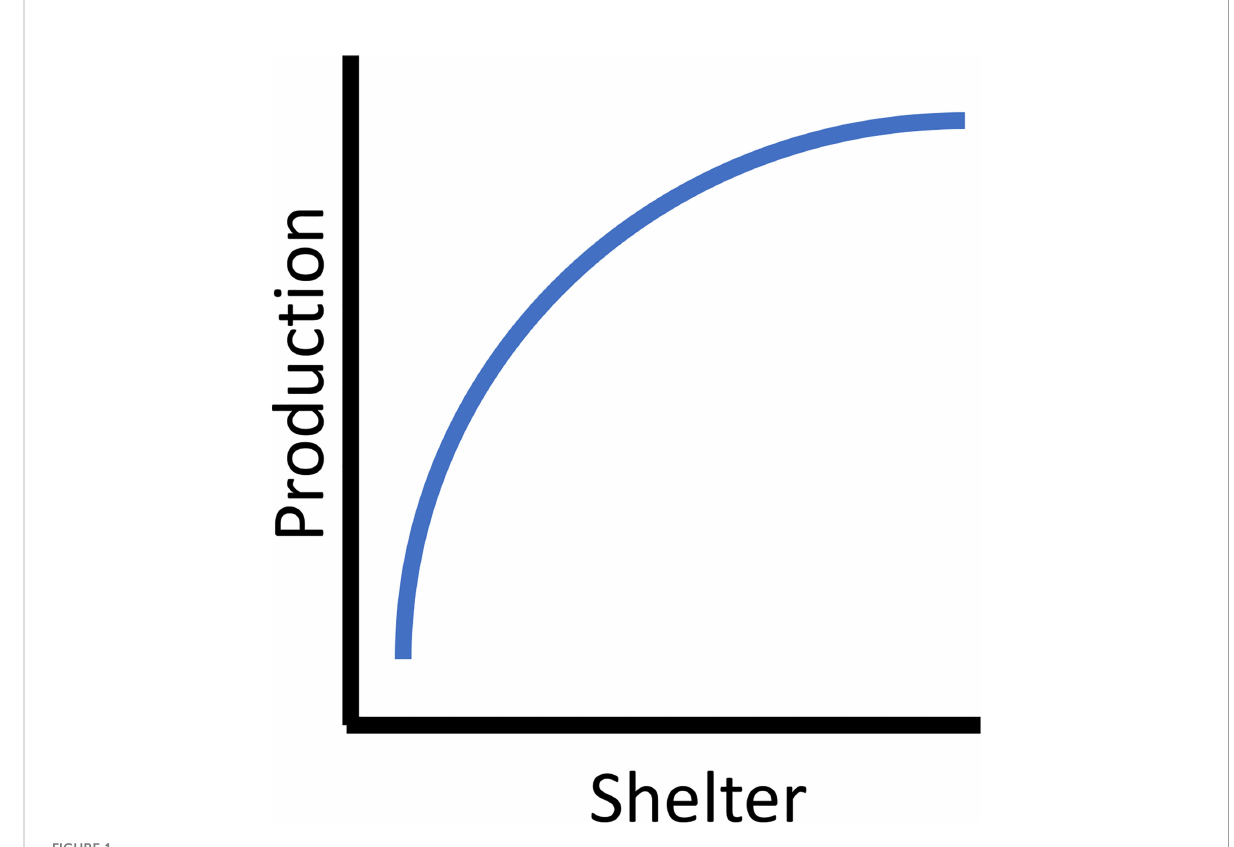
FIGURE 1 The asymptotic theoretical relationship between available shelter and secondary ( fi sh)